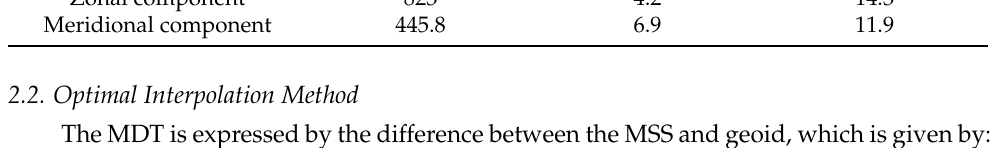
Table 3. Statistics of the errors of the drifter geostrophic velocity (units: mm/s). Geostrophic